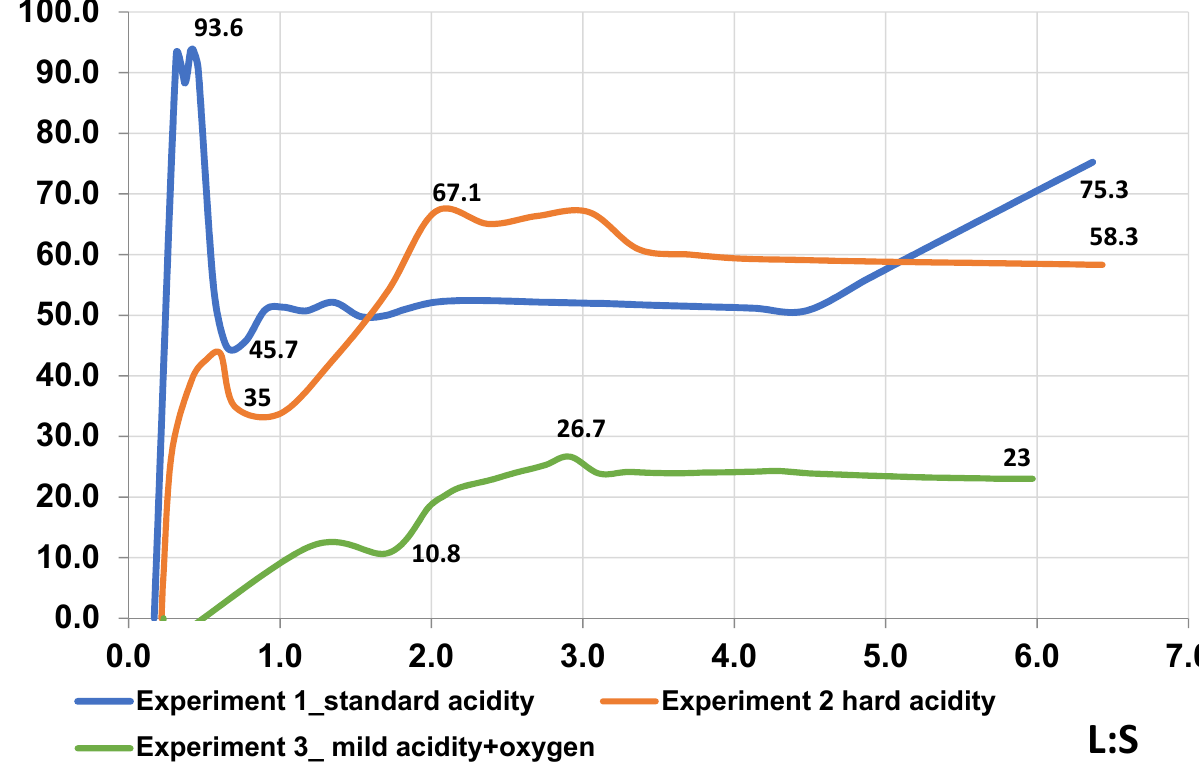
Figure 5. Consumption of sulfuric acid depending on L:S of the process.